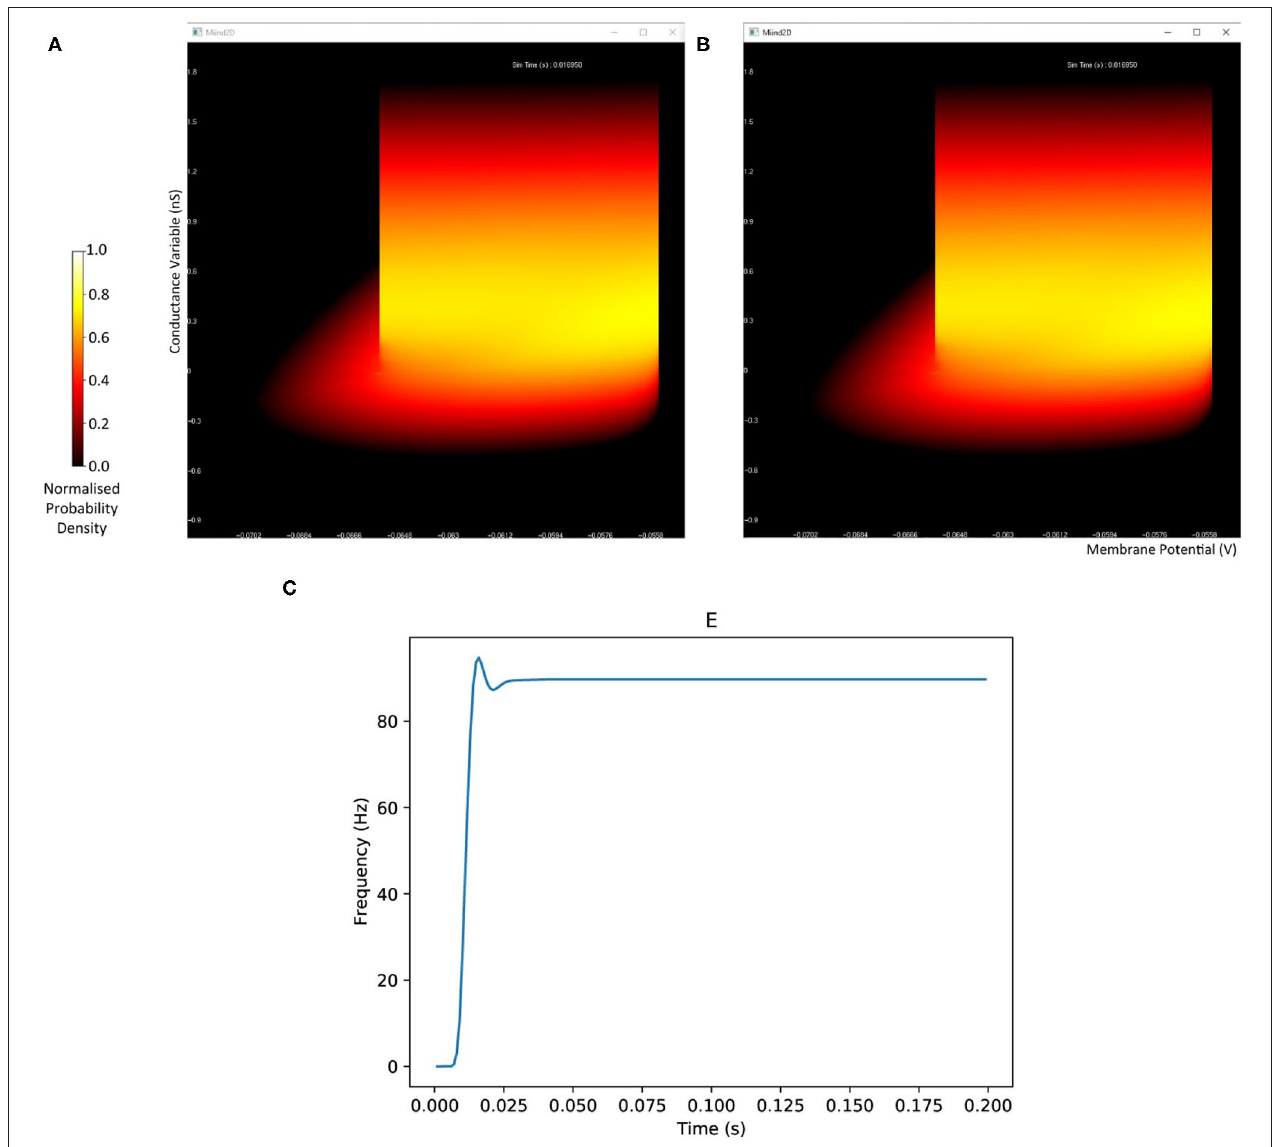
FIGURE 2 | The display output of a running E-I population network simulation of conductance based neurons. (A) The probability density heat map (normalised to the maximum density value) of the excitatory population. (B) The probability density heat map of the inhibitory population. Brighter colours indicate a larger probability mass. The axes are unlabelled in the simulation windows as the software is agnostic to the underlying model. However, the membrane potential and conductance labels have been added for clarity. (C) The average firing rate of the excitatory